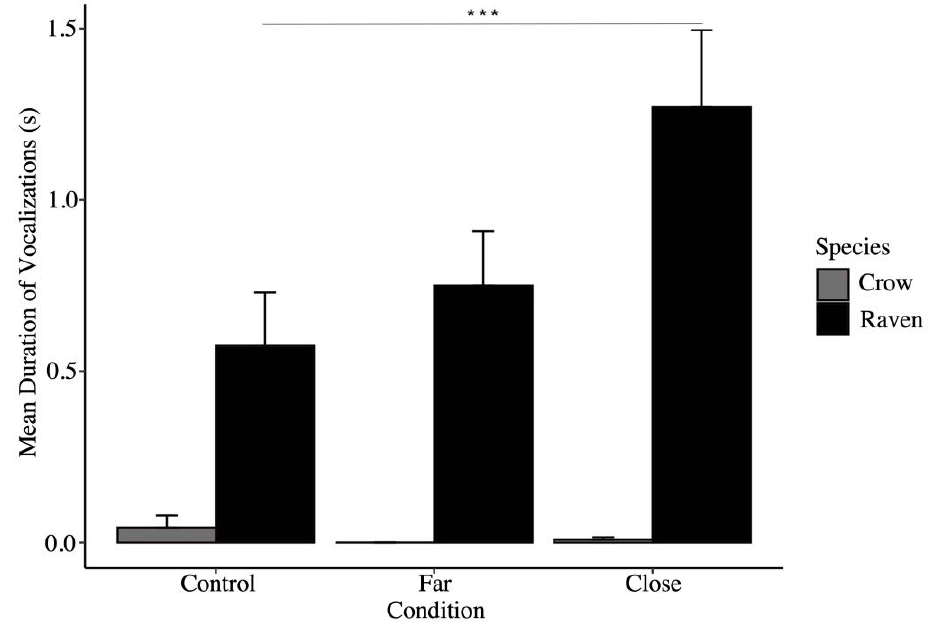
Mean Duration and Standard Error of Vocalizations in Seconds per Visitors’ Condition in Crows and